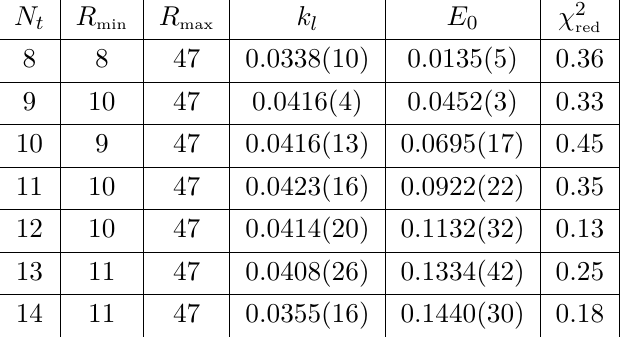
Table 8 . Best-fit estimates for E 0 for different values of N t at β = 12 . 15266 .